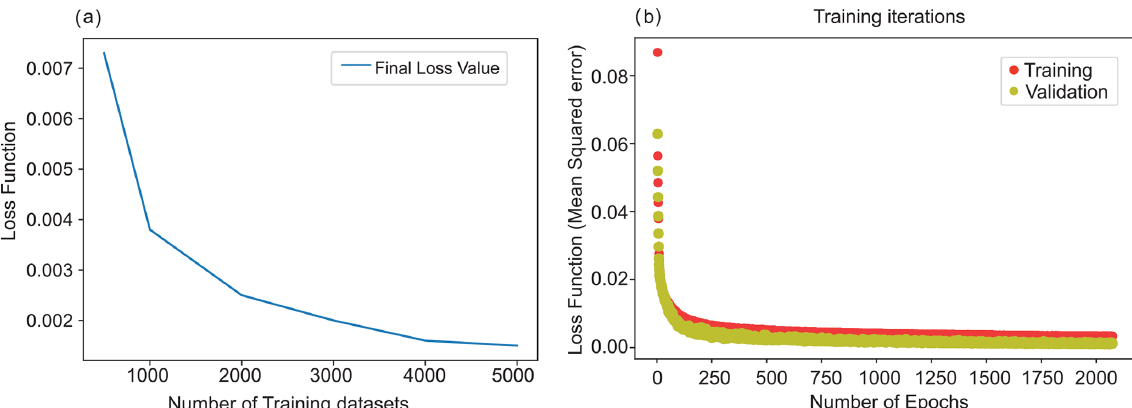
Figure 6. (a) Relationship between the loss function of the validation and the number of training data sets selected for the inverse model. The results of the training improved as the number of training data sets increased, while it slightly varied after 5000 training data sets. (b) History of learning indicated by the variation of the loss function (mean squared error). Both values of the loss function for the training and validation data sets reached a minimum value, indicating that overlearning did not occur.